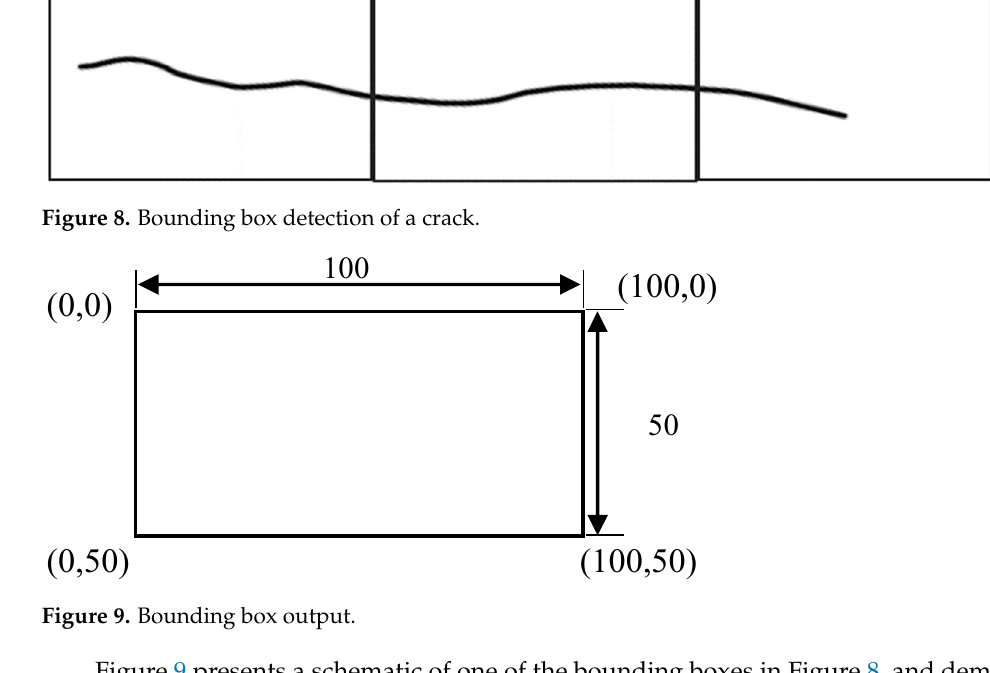
Figure 7. YOLOv4 model architecture [23].